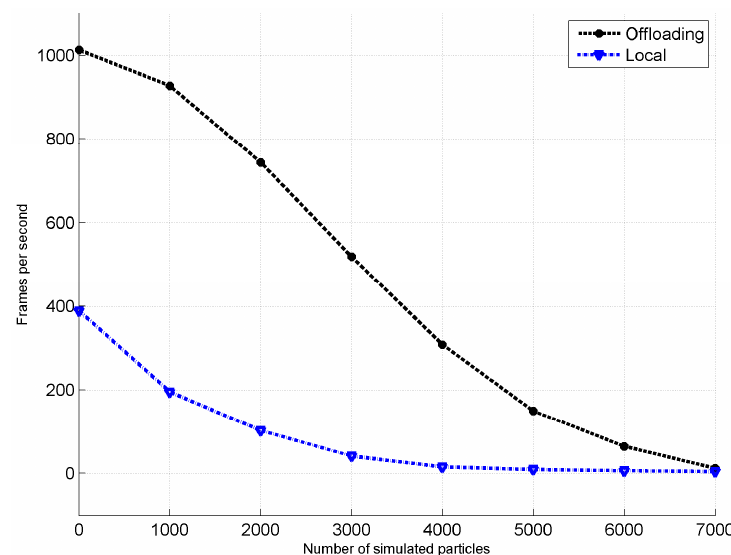
Figure 9. Number of frames per second rendered vs. the number of simulated particles in soft body.